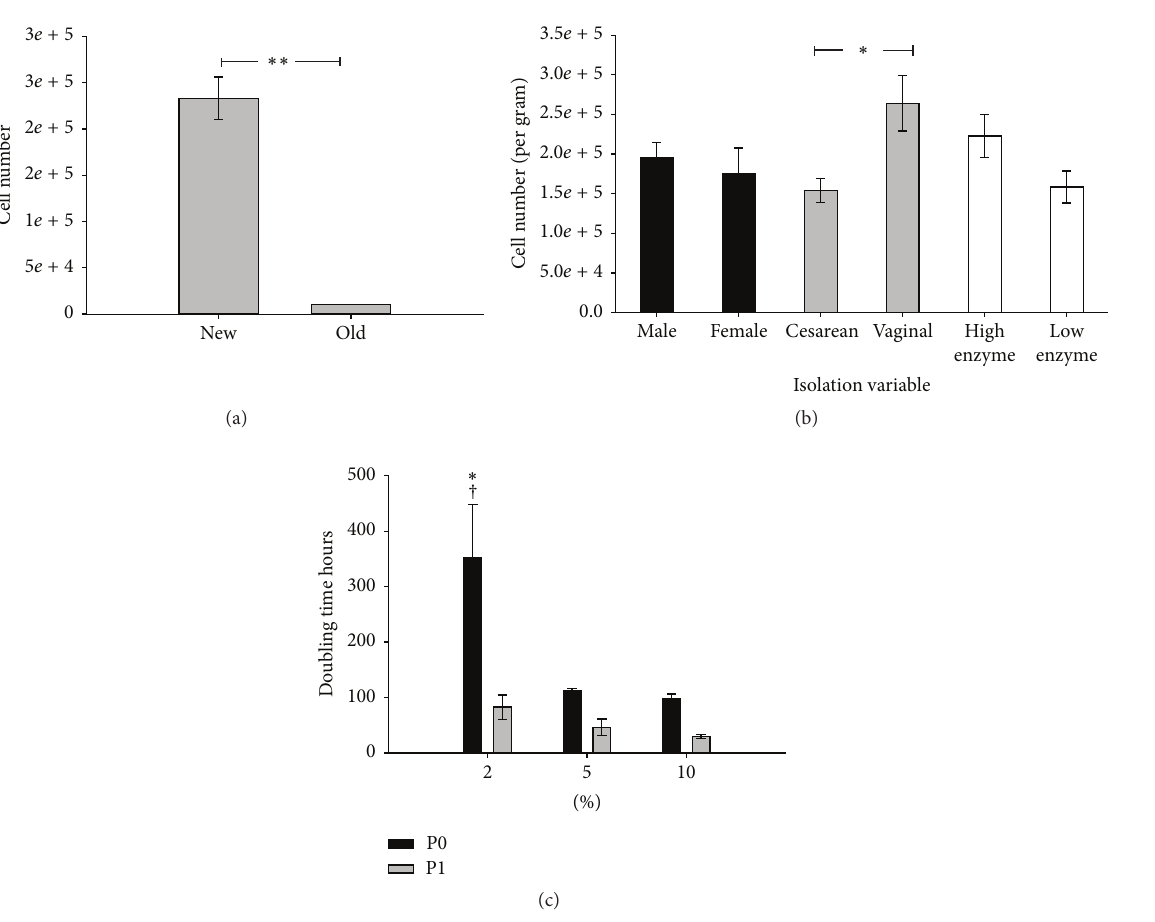
Figure 2: Effect of various experimental variables on UC-MSCs isolation. (a) The new methods average cell number per cm of umbilical cord isolated, compared to the old cell number isolated per cm ( ∗∗ means 𝑝 < 0.001 ). (b) Comparing different experimental variables. Significant difference observed in Caesarean-section delivery versus vaginal delivery ( ∗ means 𝑝 < 0.05 ). (c) Population doubling time for passage 0 (initial isolation) or passage 1 (first passage of expansion phase). ∗ represents 𝑝 < 0.05 for 2% hpl media compared to 5% and 10% media. † represents 𝑝 < 0.05 for the passages (P0 compared to the